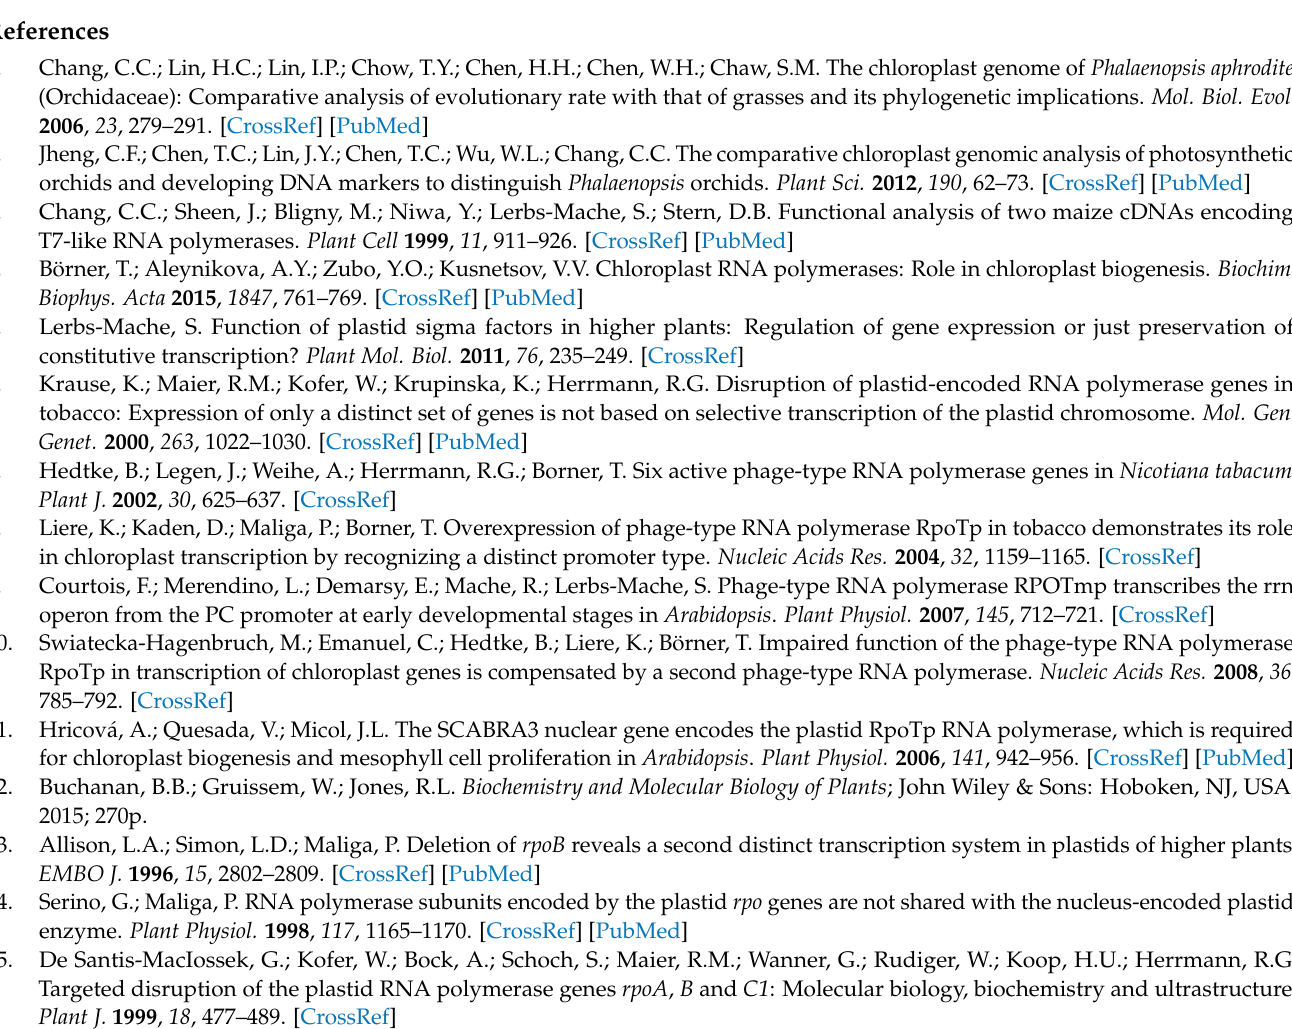
Figure S2. The distribution pattern and nucleotide coverage of DNA-Seq reads mapped to the tobacco mtDNA among transgenic plants, Figure S3. The distribution pattern and coverage of RNA-Seq reads by mapping to the tobacco mtDNA template between PEP-deficient tobacco and wild-type plants, Figure S4. The differentially expressed genes (DEGs) between PEP-deficient tobacco and wild-type plants, Figure S5. The KEGG pathway enrichment analysis for the differentially expressed genes (DEGs) between PEP-deficient tobacco and wild-type